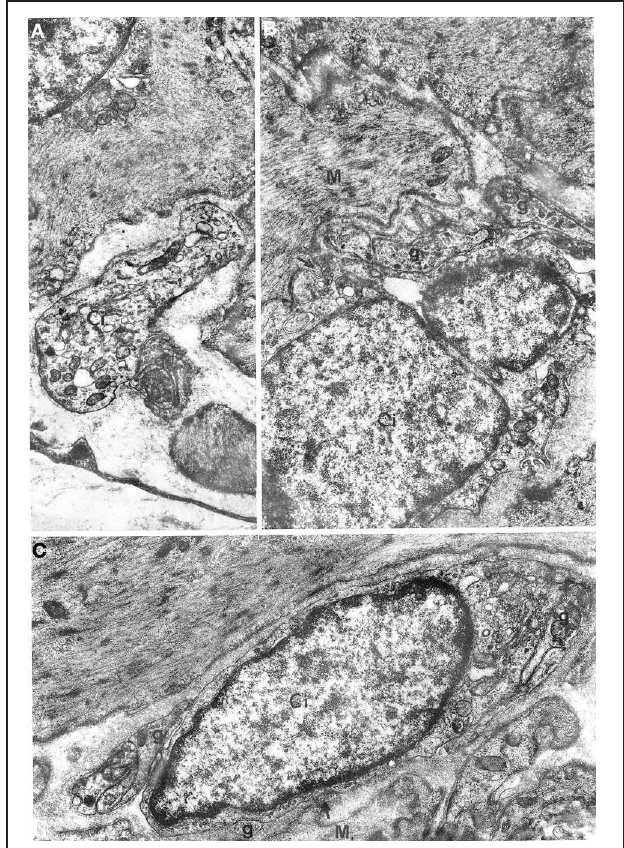
FIGURE 5 | Oesophageal muscle coat. Relations between nerve fibers and interstitial cells are shown. (A) g: junctions between interstitial cells (Ci) and nerve fibers; arrows in (B,C) point to close contacts between interstitial and muscle (M) cells. A: × 5700. B: × 14,300. C: